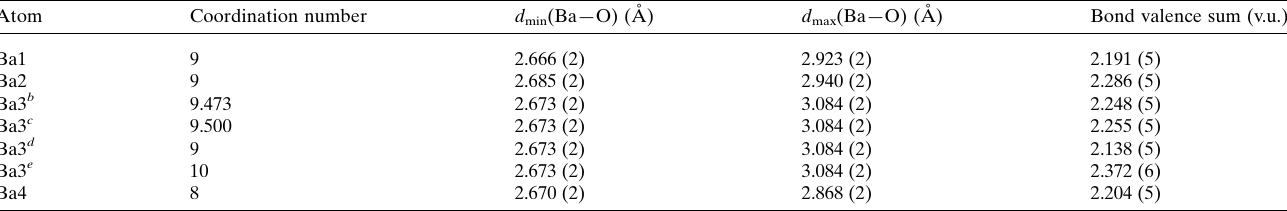
Table 1 Bonding properties of Ba 2+ cations a in the title structure. Atom Coordination